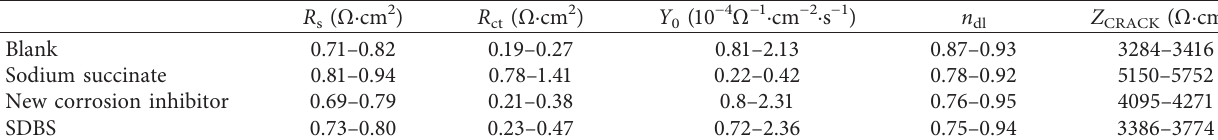
Figure 12: Fitting circuit of nyquist diagram: (a) equivalent circuit before cracking; (b) equivalent circuit after cracking. Table 1: Fitting parameters of equivalent